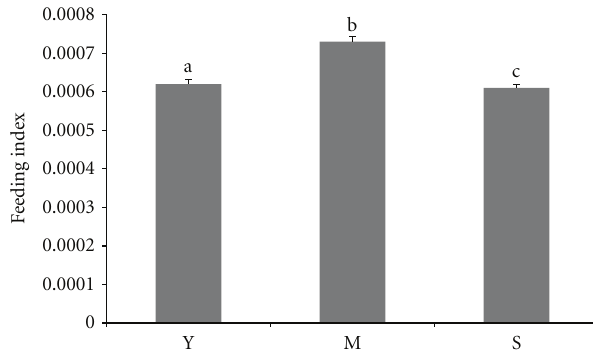
Figure 3: Feeding index of D. casignetum when reared with young (Y), mature (M), and senescent (S) sunflower leaves. Means ± SE of five observations. The di ff erent letters over the three bars indicate that the means are significantly di ff erent at P < 0 . 05.